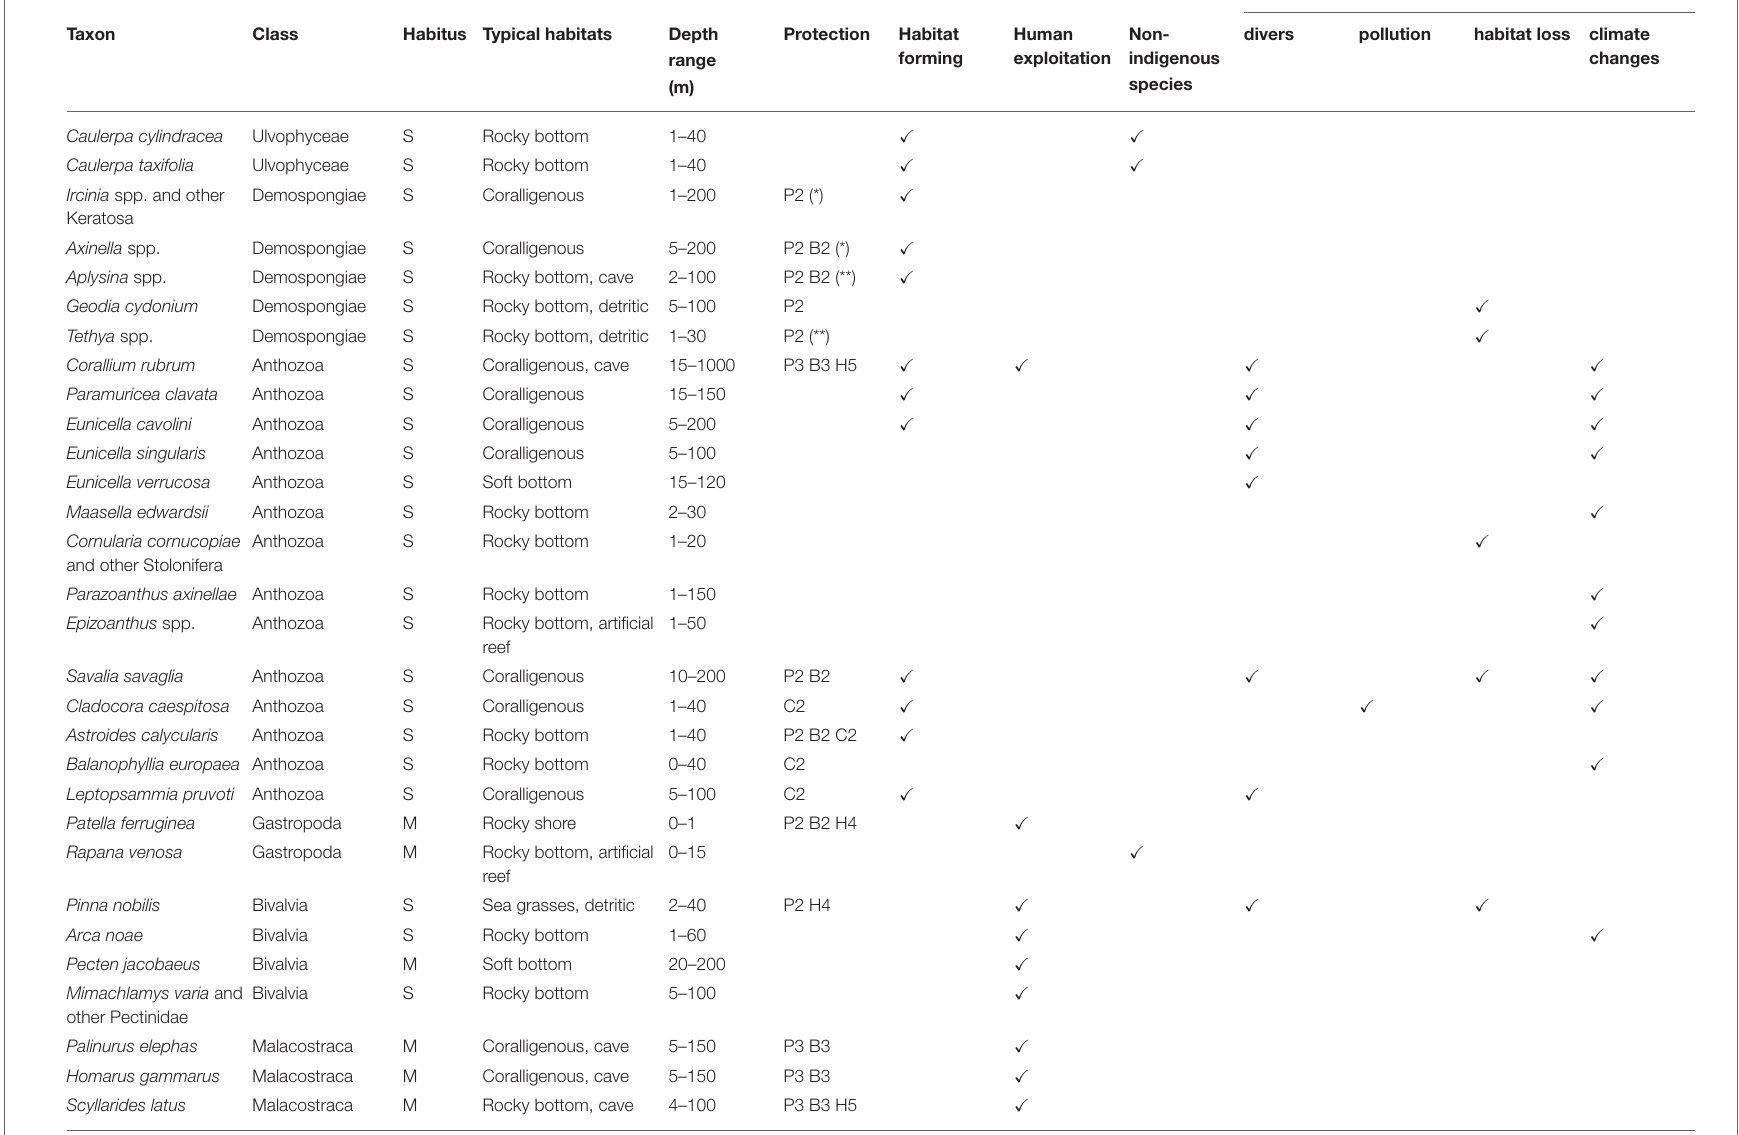
TABLE 1 | The selected taxa, the criteria that they meet, and their main